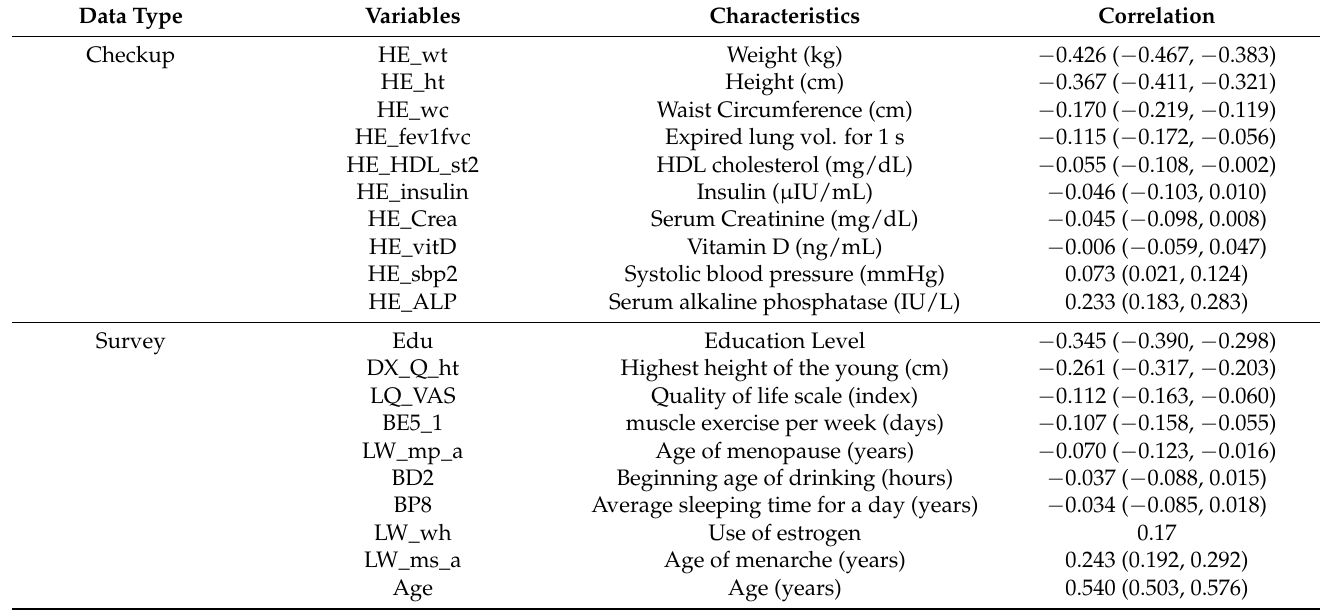
Table 2. The results of univariate correlation analysis with the list of 20 independent variables and dependent